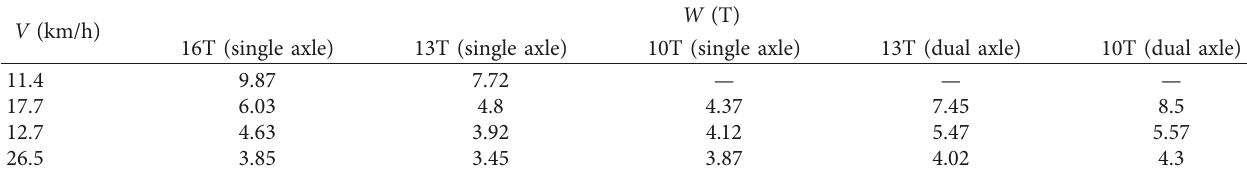
Table 10: Time accumulation of stress.